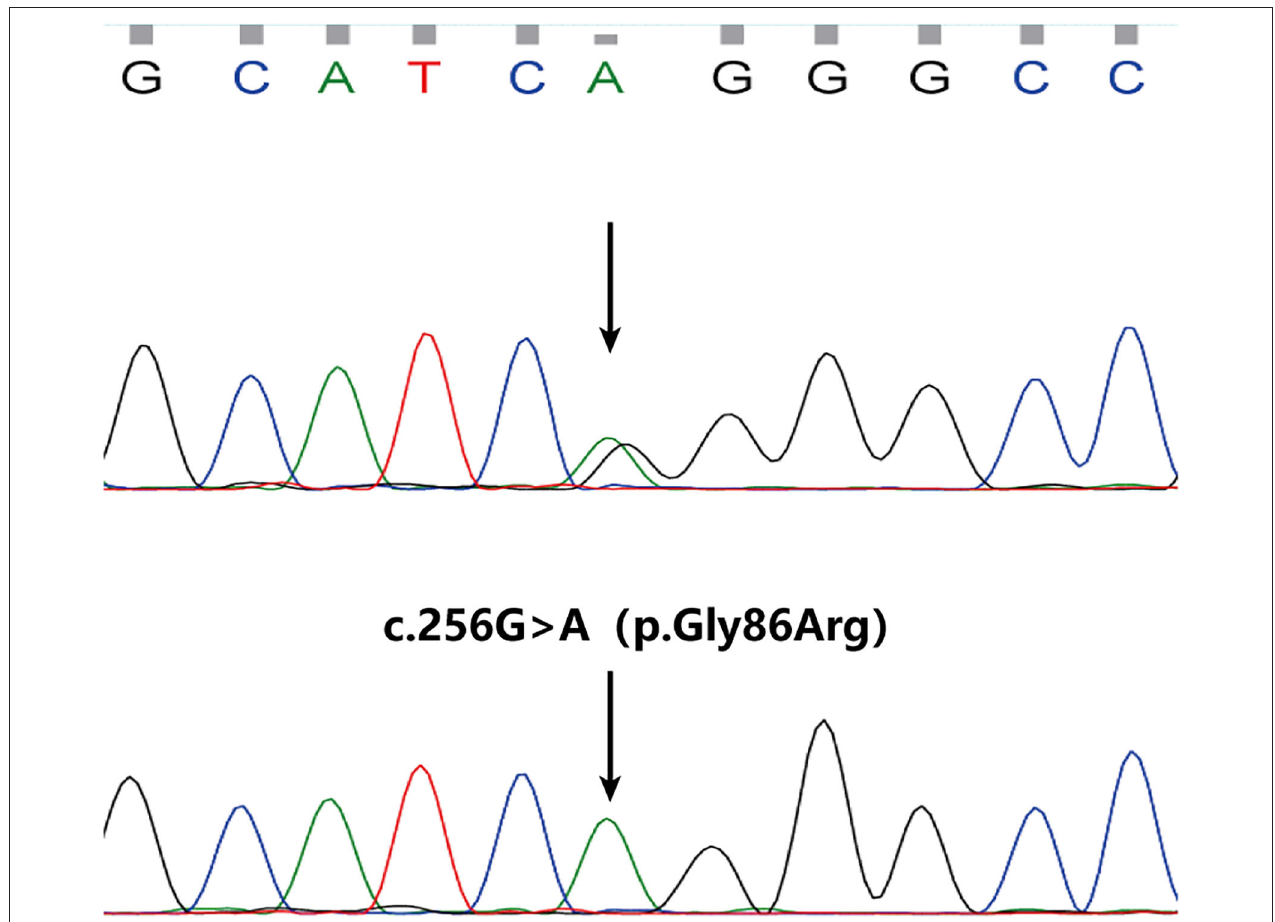
FIGURE 3 | A homozygous mutation in SLURP1 identified in the proband (the lower) and sequencing result of his parents (normal, the upper).